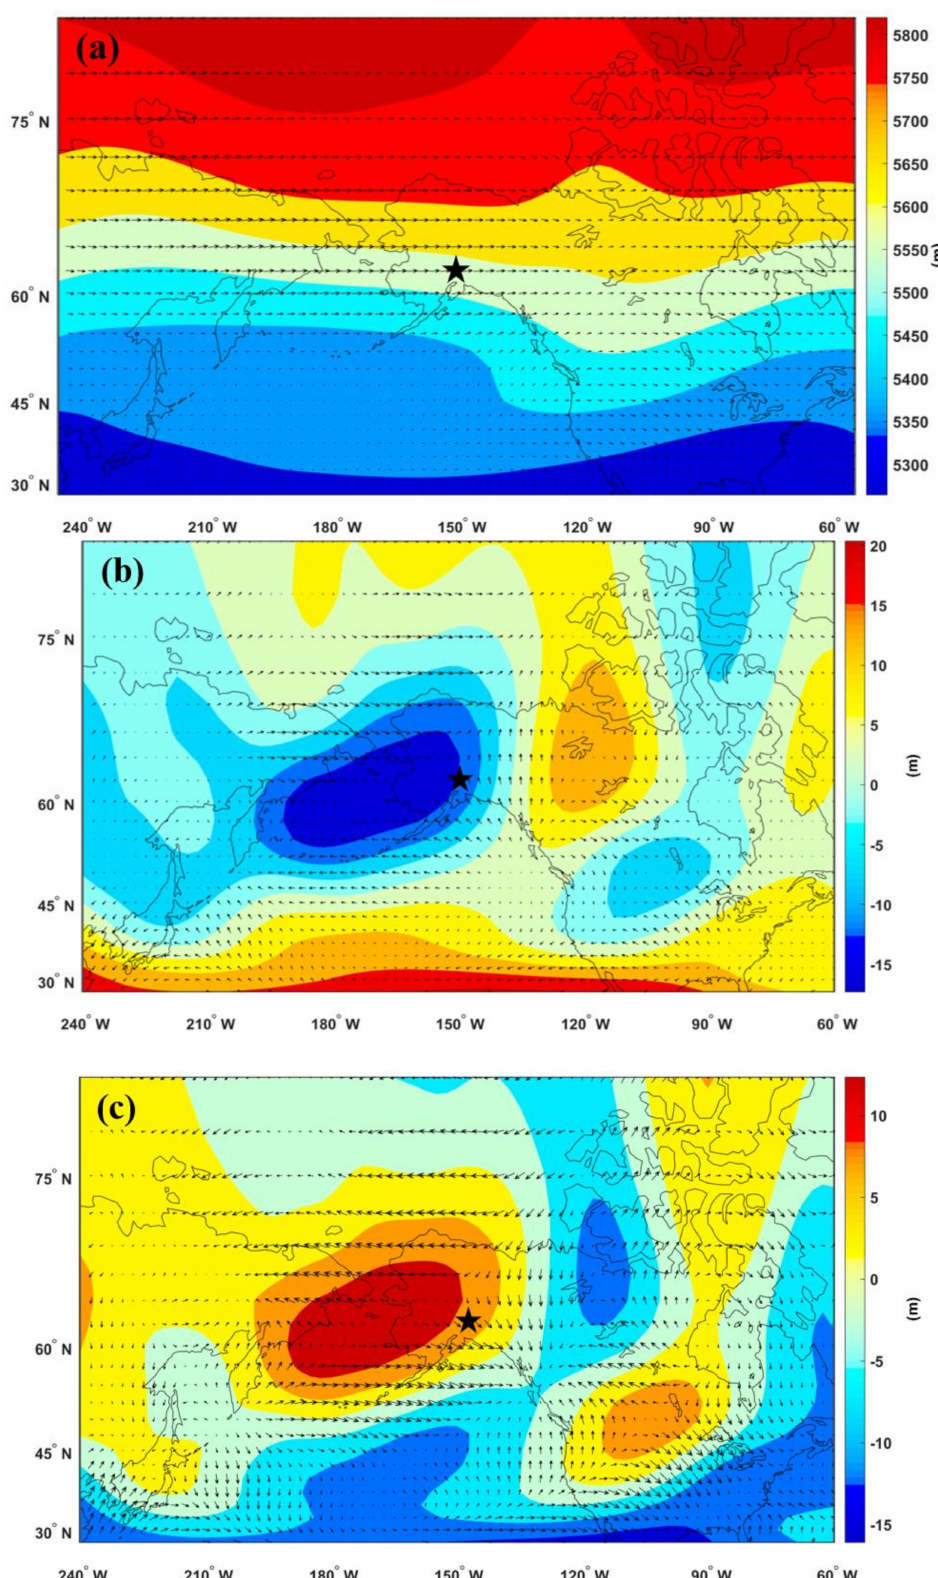
Figure 10. ( a ) Mean geopotential height in meters (colored contours) and mean wind speed in m/s (wind vectors) at 500 hPa for April–May of 1987–2015. Anomalous geopotential height and wind speed were calculated and plotted for the period April–May of 1987–1998 ( b ) and 1999–2015 ( c